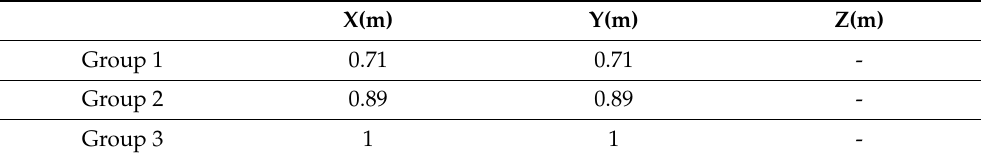
Table 2. Results of method 2 in different groups of